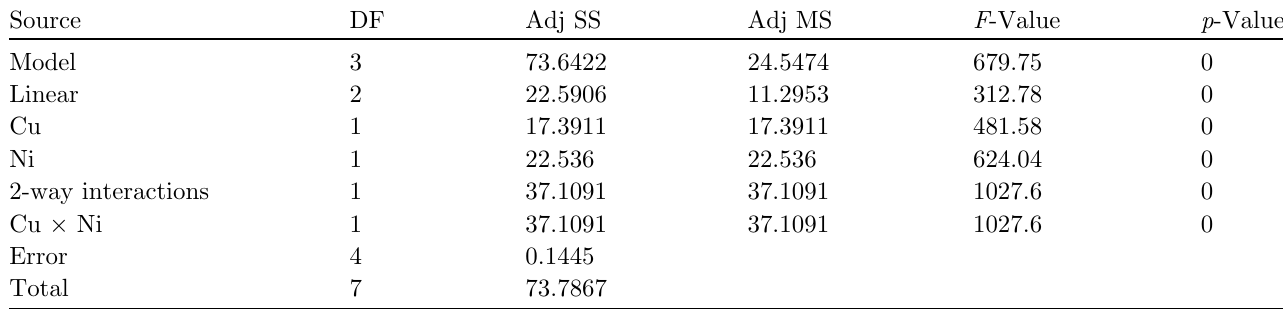
Table 2. Analysis of